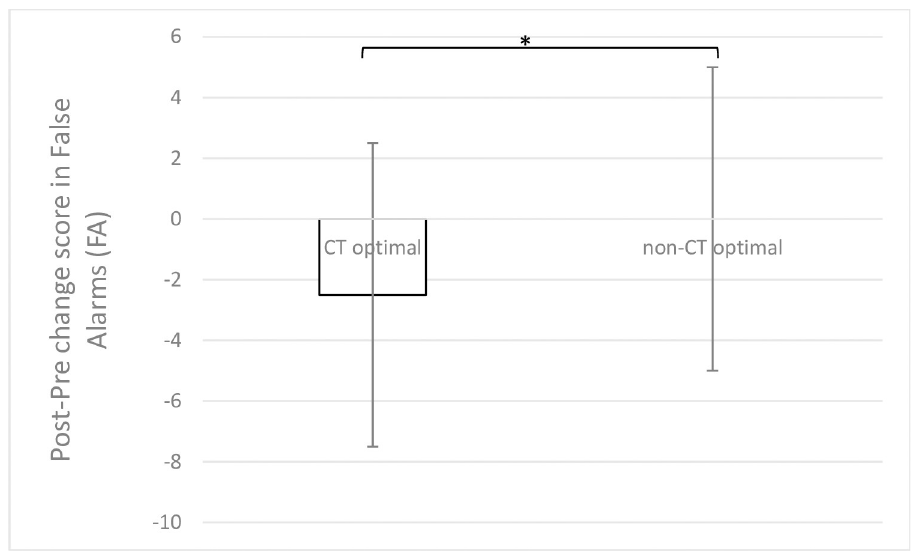
Fig 4. Median change score in FA between the first (Pre) and the second (Post) repetition of the SSDT in the CT optimal and non-CT optimal group. Error bars show interquartile ranges (IQR). The CT optimal group showed a stronger decrease in FA during the second repetition (Post) of the SSDT as compared to the non-CT optimal group. https://doi.org/10.1371/journal.pone.0261060.g004 showed a significantly higher d’ in the CT optimal vs the non-CT optimal group only after the touch manipulation (Post; t (64) = 2.36, p = .022, d = .57; CT optimal: M = 1.54, SD = .90; non- CT optimal: M = 1.05, SD = .77, see Fig 5). This difference may reflect the fact that a decrease in FA after the touch manipulation was found in the CT optimal group only. Conversely, there was no between-groups difference in d’ before the touch manipulation (Pre; t (64) = .84, p = .403, d = .21).